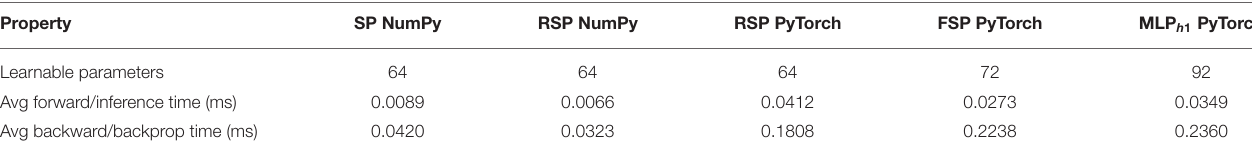
TABLE 7 | Spatial complexity and learning times of different architectures for learning in parallel all 16 functions from the Binary Boolean Function Space for different implementations of the signal perceptron and MLP with one hidden layer. Property SP